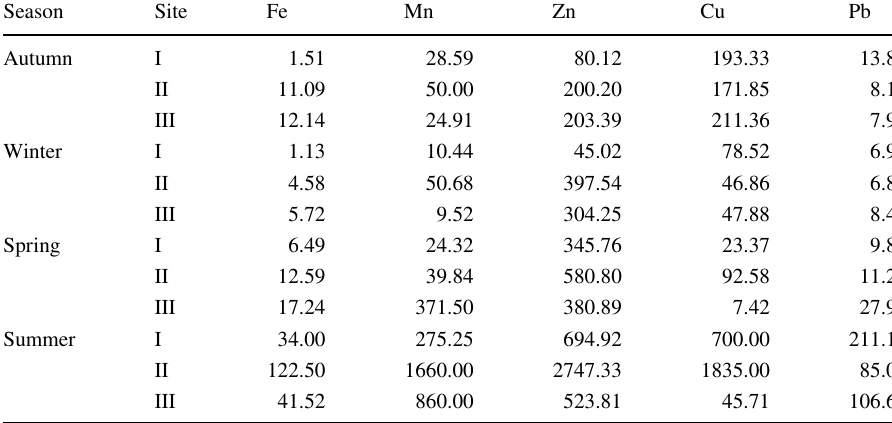
factor (L/Kg) of different heavy metals in flesh of Nile Tilapia at different station from autumn 2018 to summer